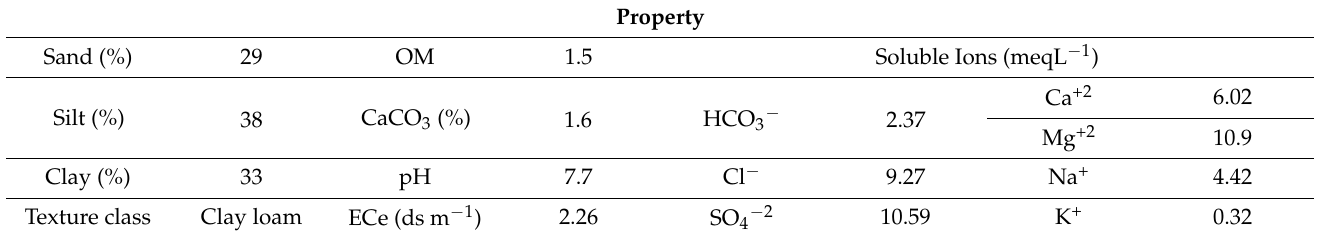
Table 1. The physical and chemical properties of the experimental soil.